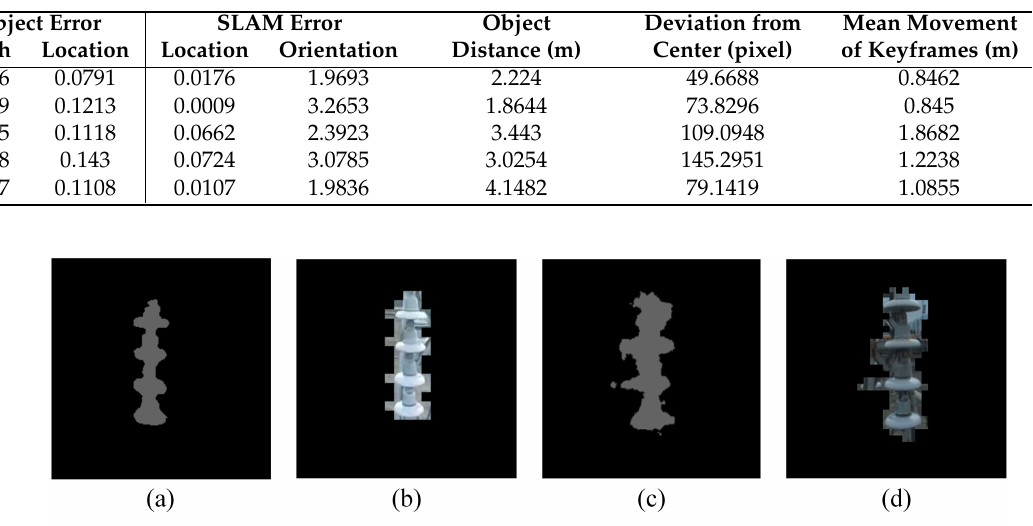
Figure 12. The difference between manual segmentation and automatic segmentation. ( a , b ) The example of manual segmentation and its gridded RoI. ( c , d ) The example of automatic segmentation and its gridded